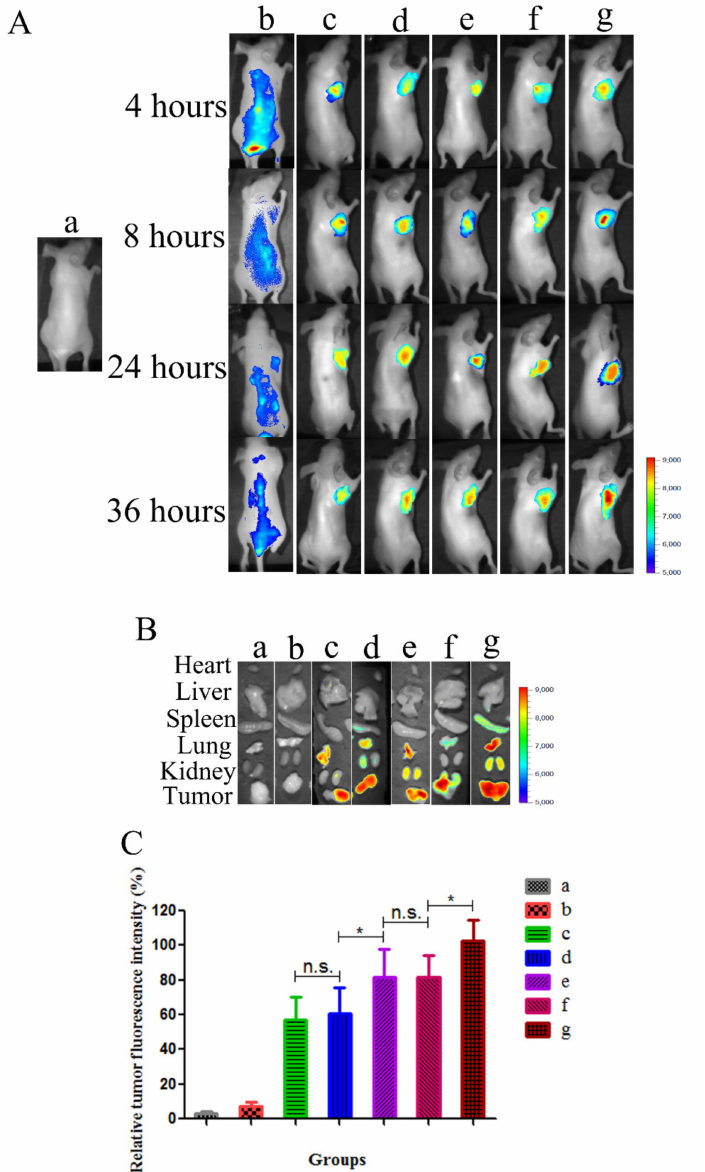
Figure 6. Bio-distribution study of modified DiR-NLC in tumor-bearing mice. ( A ) Fluorescence images of mice treated with different DiR formulations in vivo at different time points (4, 8, 24, and 36 h). ( B ) Ex vivo fluorescence images of the organs and tumor tissues excised from mice treated with different DiR formulations. ( C ) Fluorescence signal of tumor obtained from mice treated with different DiR formulations. Results are expressed as mean ± SD, * p < 0.05. n.s., not significant. In Figure 6, a: Sal, b: DiR-Sol, c: DiR-NLC, d: dNP2-DiR-NLC, e: FA-DiR-NLC, f: FA/dNP2-DiR-6-NLC and g: